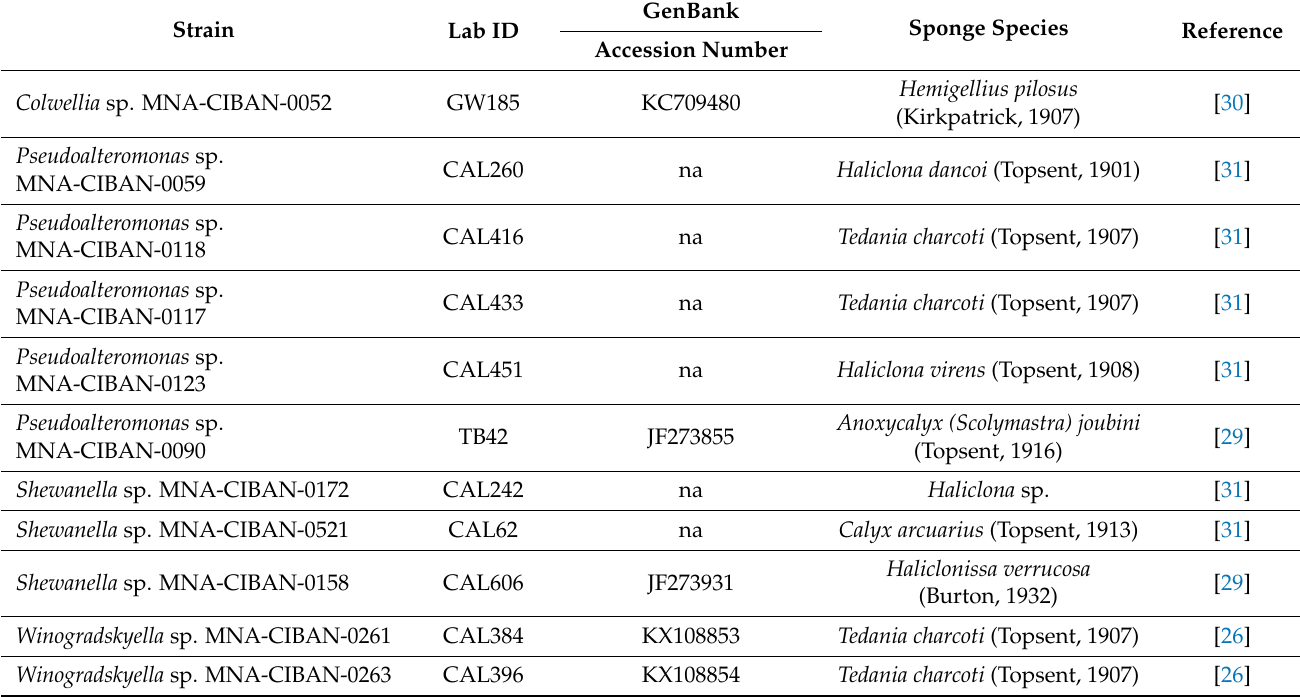
Table 1. Origin of Antarctic sponge-associated bacteria used in this study (na: not assigned). Strain Lab ID